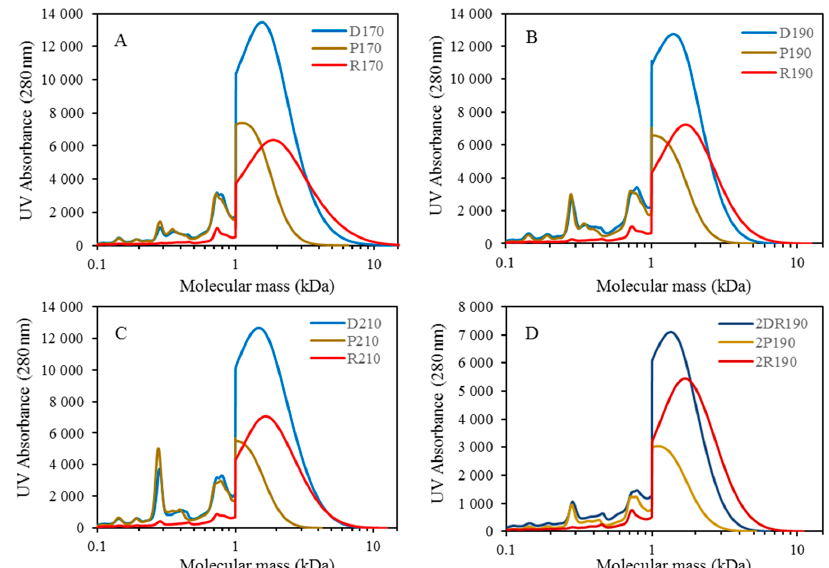
Figure 7. Comparison of the molecular weight distribution of untreated 170–210 °C depolymerized BLR, untreated second round 190 °C depolymerized BLR, the permeate after membrane filtration of the 4 samples, and the retentate after membrane filtration. ( A ) Untreated 170°C depolymerized BLR (D170), the permeate after membrane filtration (P170), and the retentate after membrane filtration (R170). ( B ) Untreated 190°C depolymerized BLR (D190), the permeate after membrane filtration (P190), and the retentate after membrane filtration (R190). ( C ) Untreated 210°C depolymerized BLR (D210), the permeate after membrane filtration (P210), and the retentate after membrane filtration (R210). ( D ) Untreated second round 190°C depolymerized BLR (2D190), the permeate after membrane filtration (2P190), and the retentate after membrane filtration (2DR190).